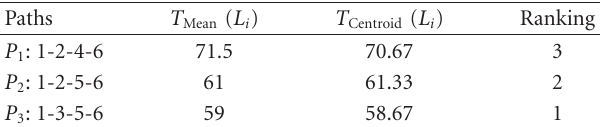
Table 1: Results of the network based on level λ -triangular LR intersection index.